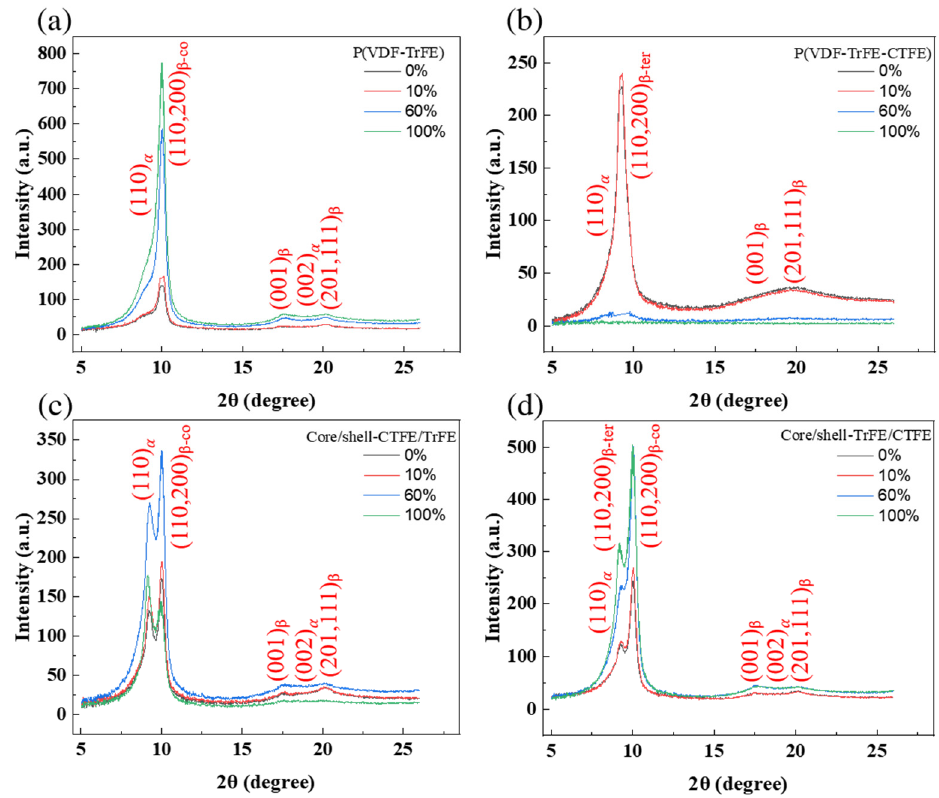
Figure 4. 1D WAXS intensity profiles and corresponding peak fitting in the ( a ) single P(VDF-TrFE), ( b ) single P(VDF-TrFE-CTFE), ( c ) core/shell-CTFE/TrFE, and ( d ) core/shell-TrFE/CTFE in RD.